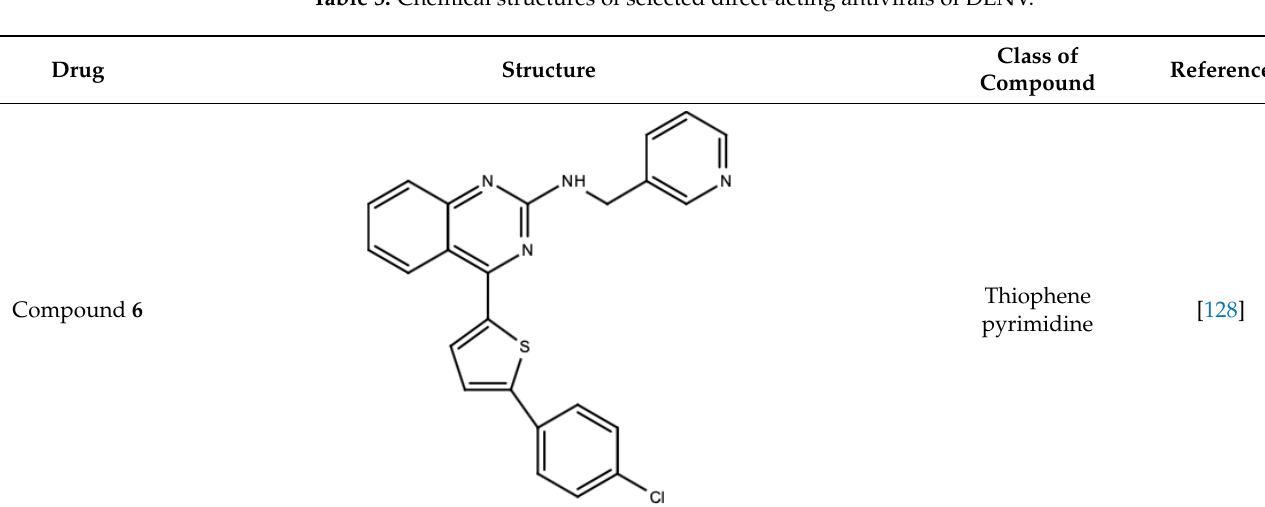
Table 5. Chemical structures of selected direct-acting antivirals of DENV.